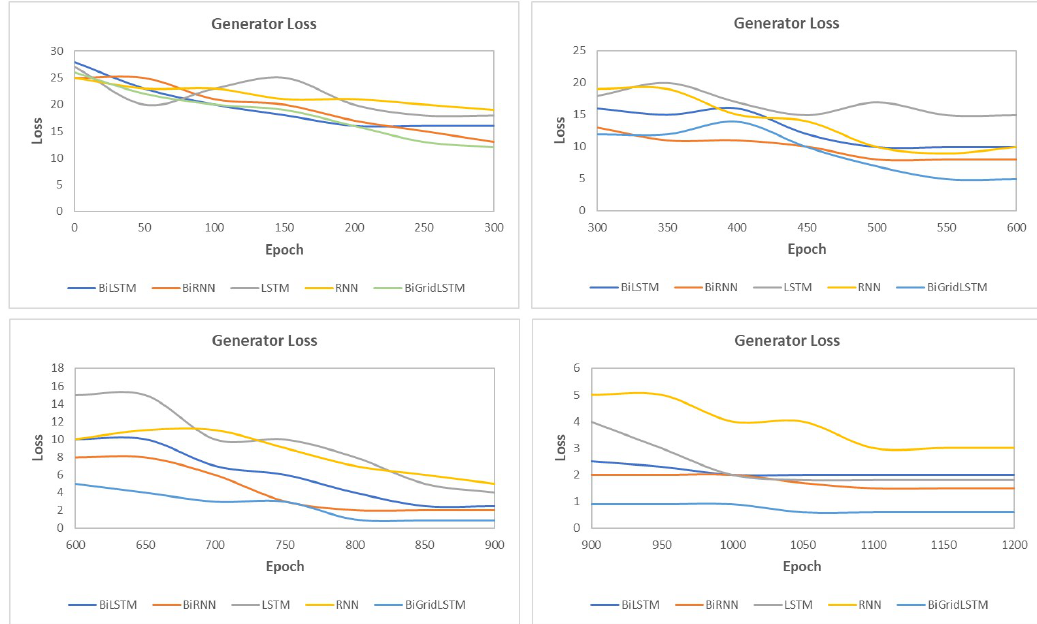
Figure 12. Loss for different generators with CNN as the discriminator in the generative adversarial networks (GAN) architecture.